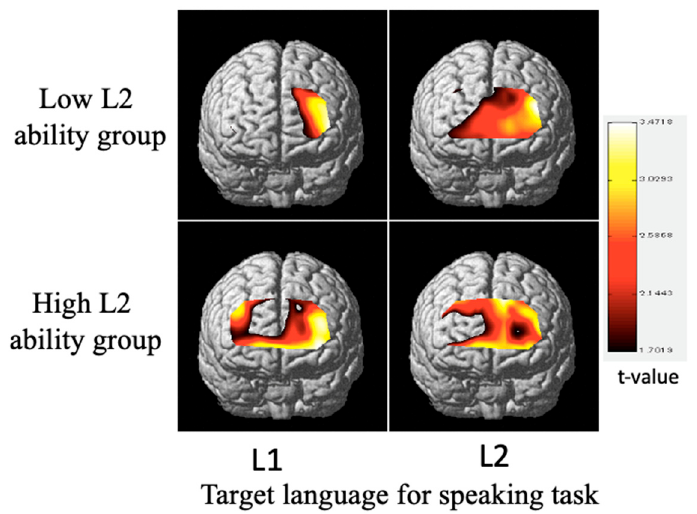
Figure 8. Regions of common activation, obtained by NIRS-SPM, in the prefrontal cortex of native speakers of Mandarin (L1) who speak Japanese (L2) by L2 ability ( p <